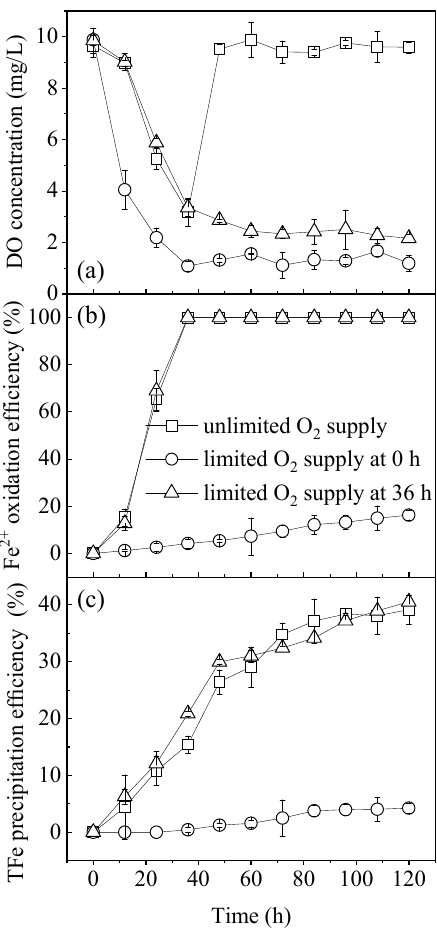
Figure 5. E ff ects of O 2 supply time on the ( a ) DO concentration, ( b ) Fe 2 + oxidation and ( c ) TFe Figure 5. Effects of O 2 supply time on the ( a ) DO concentration, ( b ) Fe 2+ oxidation and ( c ) TFe precipitation e ffi ciency during A. ferrooxidans -mediated precipitation efficiency during A. ferrooxidans -mediated biomineralization.